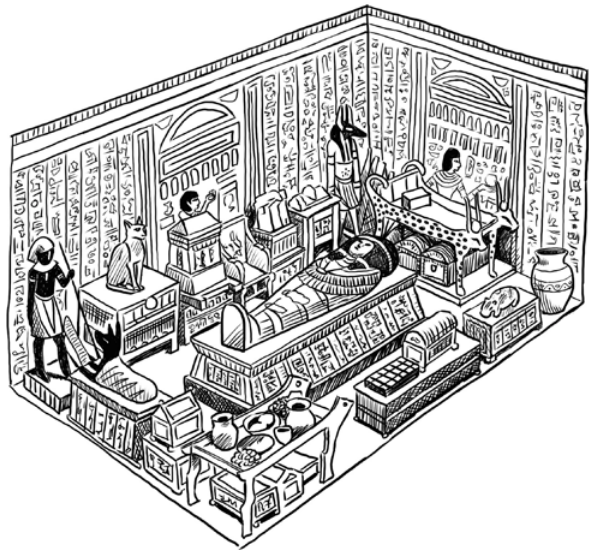
Figure 2. Interior of a tomb.